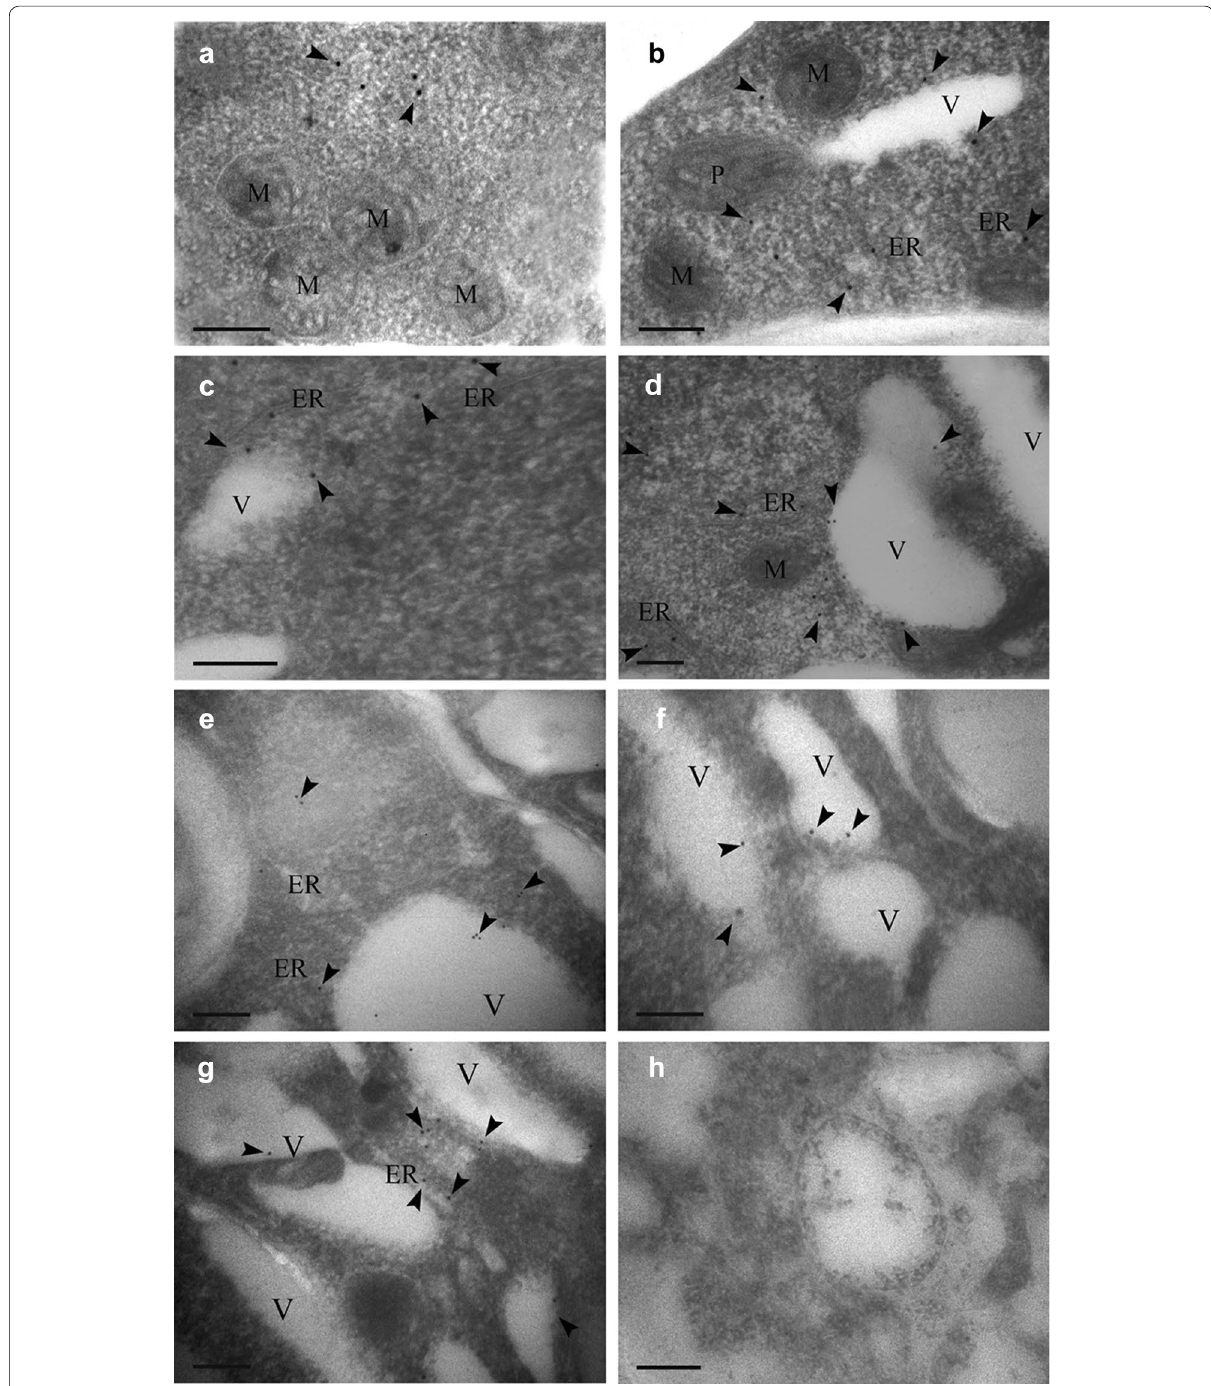
Fig. 8 Immunolocalization of the AACT in Euphorbia helioscopia laticifers. a AACT signals appeared to locate in the cytosol randomly (arrows). b AACT signals appeared to locate mainly in endoplasmic reticulum and cytosol near small vacuoles from endoplasmic reticulum (arrows). c AACT signals appeared to locate in the endoplasmic reticulum, cytosol near small vacuoles from endoplasmic reticulum (arrows). d Golden particles conjugated AACT antibodies were found to locate in the endoplasmic reticulum, cytosol near small vacuoles from endoplasmic reticulum (arrows). e AACT signals locate in small vacuoles from endoplasmic reticulum and cytosol (arrows). f AACT signals locate in small vacuoles from endoplasmic reticulum (arrows). g Golden particles conjugated AACT antibodies were found to locate in the endoplasmic reticulum, small vacuoles from endo- plasmic reticulum and cytosol between small vacuoles (arrows). h Negative controls showed no gold labeling in the laticifer cells. Bars ER, Endoplasmic reticulum; M, Mitochondrion; P, Plastid; V,